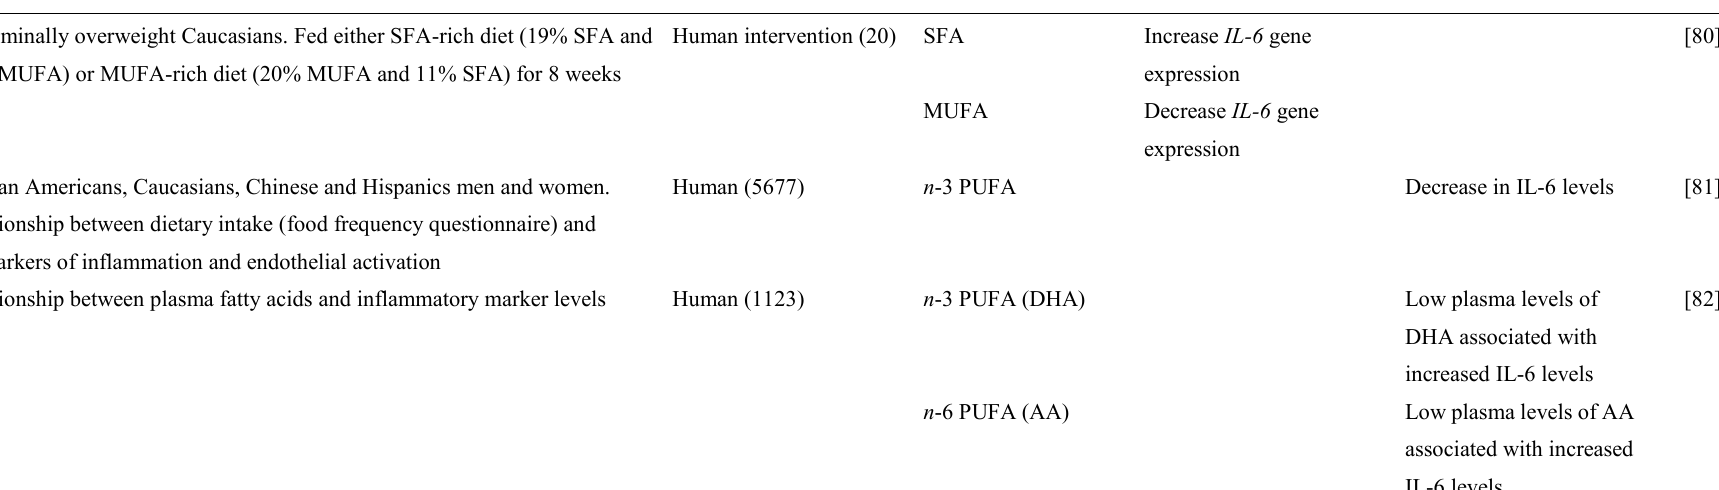
Abdominally overweight Caucasians. Fed either SFA-rich diet (19% SFA and